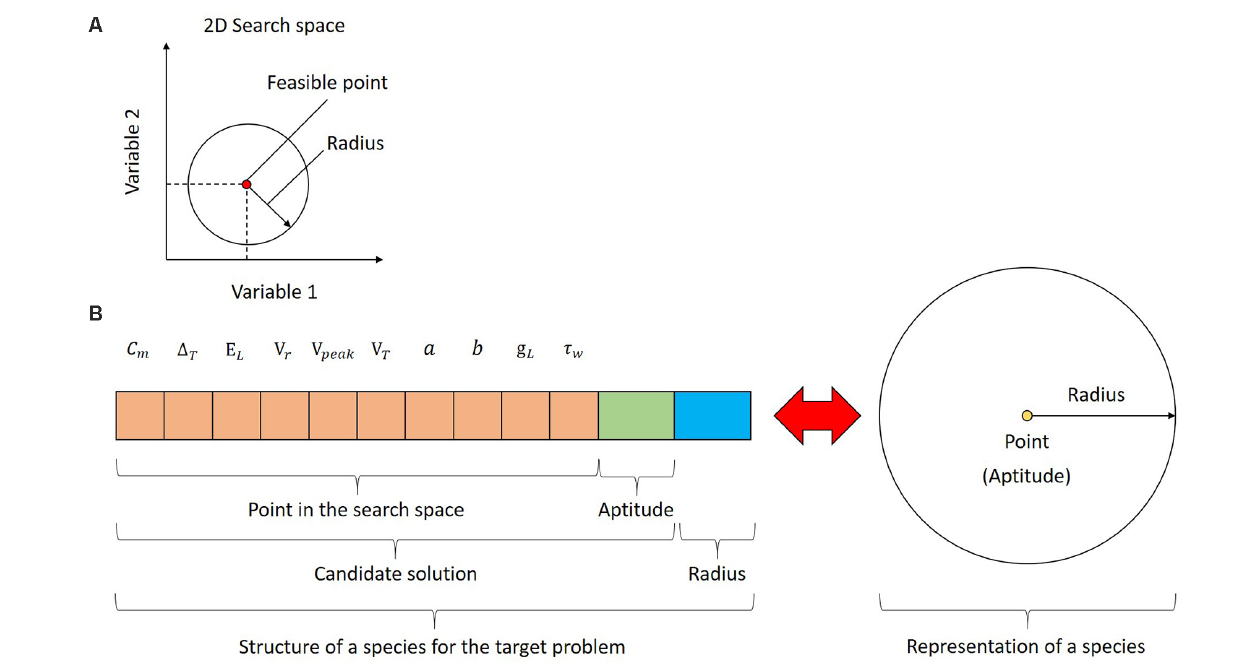
FIGURE 2 | Species in UEGO. (A) Species in the search space for a hypothetical bi-dimensional problem. The candidate solution is a feasible point, and it is linked to a particular radius around it to define a region to center the search. Both define a circumference in a two-dimensional Euclidean space, but the concept can be extended to any dimensions through hyperspheres. (B) Structure of a species for the problem at hand (on the left) and its conceptual meaning (on the right). As shown on the left, in practical terms, a species consists of three parts: (1) a feasible point in the search space with a component for each optimization variable (colored in orange); (2) the fitness of the referred point according to the objective function (colored in green); and (3) the radius linked to this species (colored in blue). UEGO will use the referred information to build a hypersphere from every species, and they will be ultimately treated as exploration windows in the search space. This aspect is shown on the right side of the figure using a plain circumference due to the impossibility of showing the corresponding hypersphere.